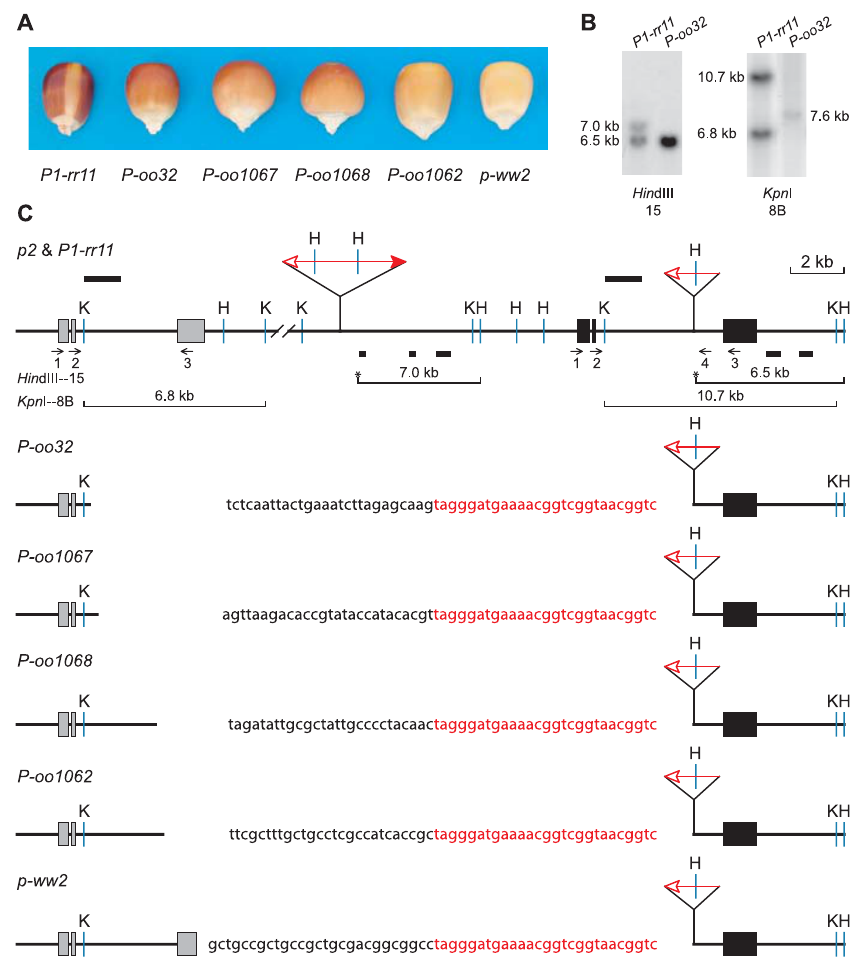
Figure 1. Phenotypes and Gene Structures of P-oo Alleles (A) The kernel pericarp pigmentation phenotypes specified by the indicated alleles. (B) Genomic Southern blot. Genomic DNA from plants homozygous for the indicated alleles was cut with KpnI and HindIII, and hybridized with probes 15 or 8B from the p1 gene. Lanes marked P-oo32 contain approximately twice as much DNA as lanes marked P1-rr11; this DNA overloading enables the detection of the 7.6-kb band in the KpnI 8B blot, but also results in the intense 6.5-kb band in the HindIII 15 blot. (C) Restriction map. The solid and gray boxes are exons 1, 2, and 3 (left to right) of p1 and p2, respectively. Red triangles indicate Ac or fAc insertions, and the open and solid arrowheads indicate the 3 9 and 5 9 ends, respectively, of Ac/fAc . Sequences hybridizing with Southern blot probes are indicated by the solid bars above (probe 8B) and below (probe 15) the map. The short horizontal arrows indicate the orientations and approximate position of PCR primers. Primers are identified by numbers below the arrows. The sequence of the junction of each fusion allele is shown here; the black letters indicate p2 sequence, while the red letters indicate fAc sequence. K, KpnI; H, HindIII. Lines below the map indicate the restriction fragments produced by digestion with KpnI or HindIII and hybridizing with the indicated probe; asterisks indicate HindIII restriction sites located within Ac or fAc sequences. DOI: